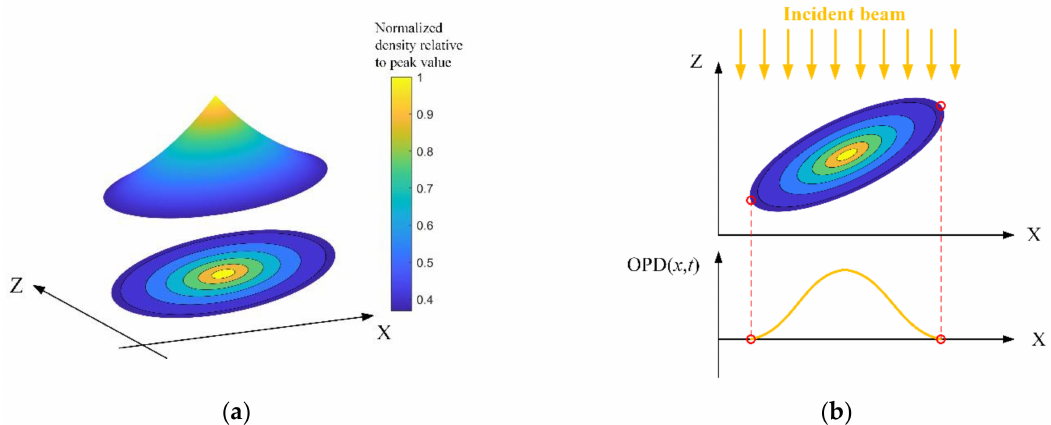
Figure 5. Layered-ellipse vortex model (X, streamwise; Z, wall direction): ( a ) Surface and projection of the layered-ellipse vortex model in two-dimensional density field; ( b ) parallel beam transmits through a layered-ellipse vortex and produces the optical path difference